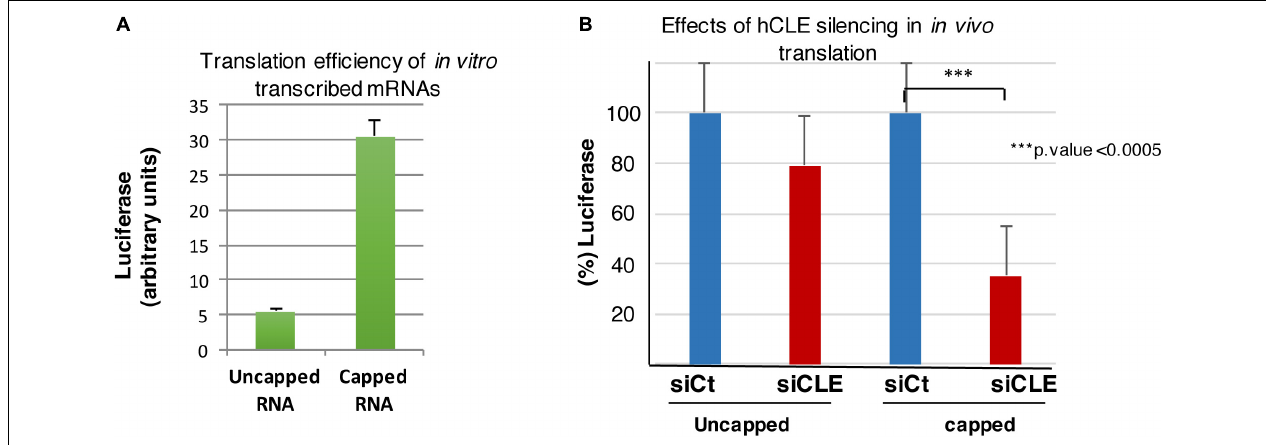
FIGURE 6 | hCLE controls cap-dependent translation. (A) In vitro transcribed luciferase RNA was left uncapped or capped and both RNAs used for luciferase determination by in vitro translation assay. (B) HEK293T cells were transfected with 0.5 µ g/2 × 10 5 cells of in vitro transcribed luciferase RNA uncapped or capped and 1.5 h post-transfection luciferase activity was analyzed. The graphic shows the percentage of translated uncapped or capped luciferase RNA in control (taking as 100%) and hCLE silenced cells. Four independent experiments with three technical replicates were done. ∗∗∗ p -value < 0.0005.